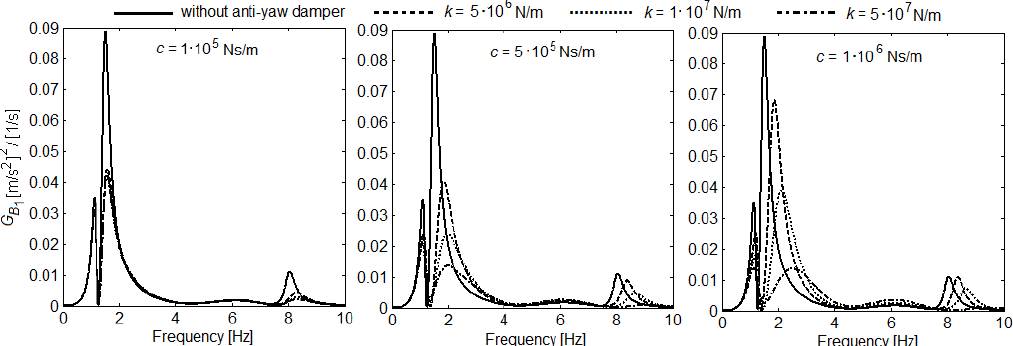
density of the carbody acceleration at the carbody center.